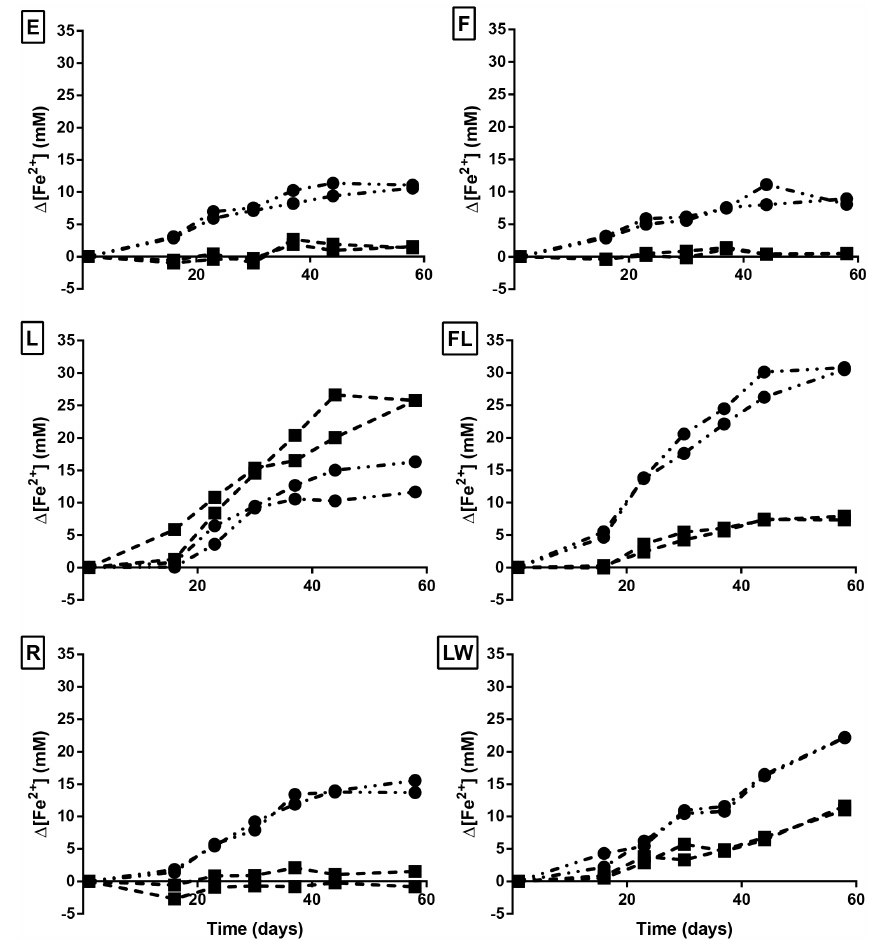
Figure 1. Microbial iron reduction in subglacial enrichments over time. Data, expressed as change in Fe 2 + concentration (mM) over time, correspond with second-generation 4 ◦ C (circles, dot-dashed line) and 15 ◦ C (squares, dashed line) Engabreen (E), Finsterwalderbreen (F), Leverett (L), fresh Leverett (FL), Russell (R) and Lower Wright (LW)